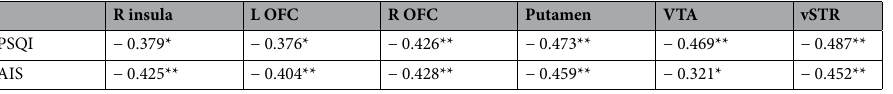
Table 4. Partial correlation matrix analysis after controlling for depression scale scores. L left side, R right side, OFC orbitofrontal cortex, VTA ventral tegmental area, vSTR ventral striatum, PSQI The Pittsburgh